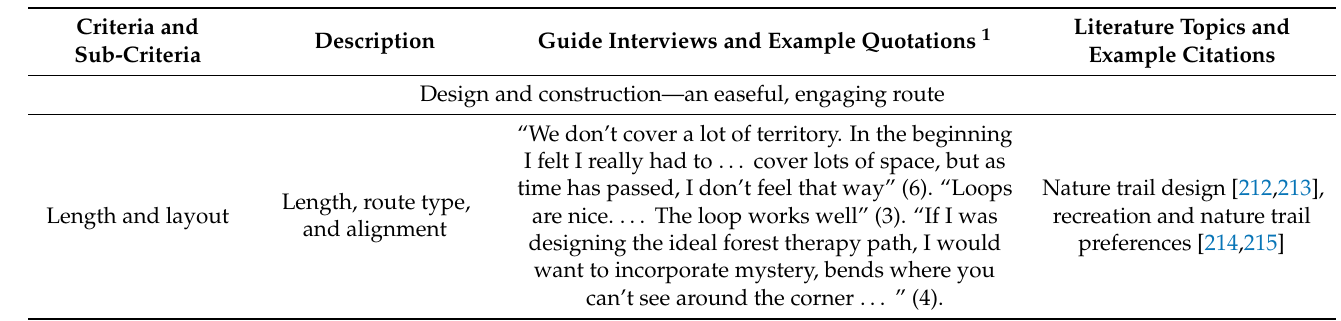
Table 2. Trail-related